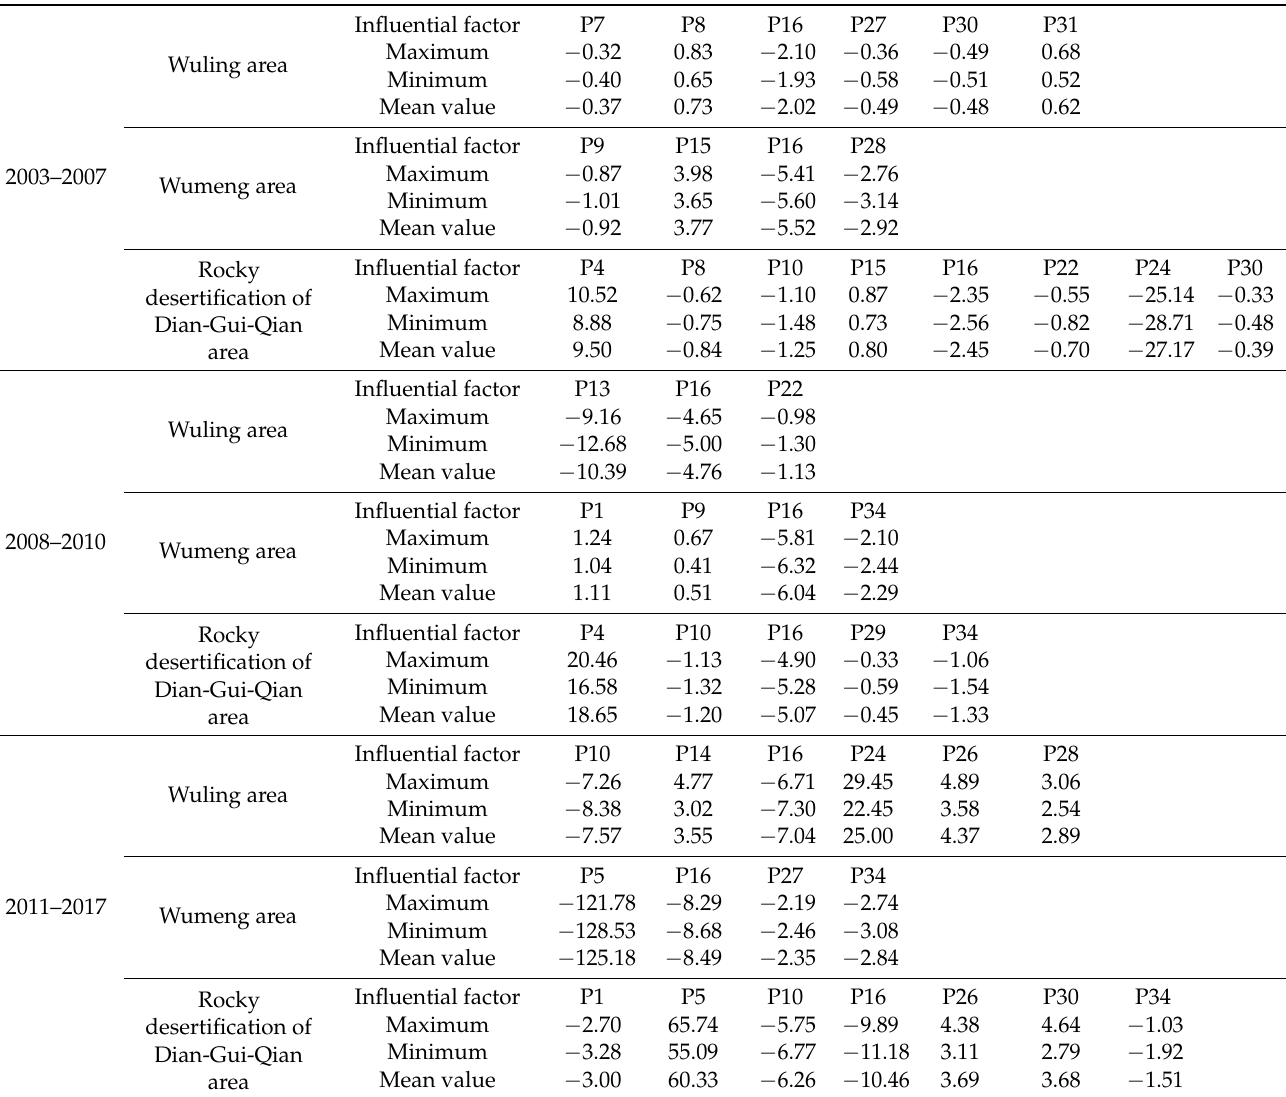
Table 2. Maximum, minimum, and mean values of the coefficients of the influential factors in the three continuously poverty-stricken